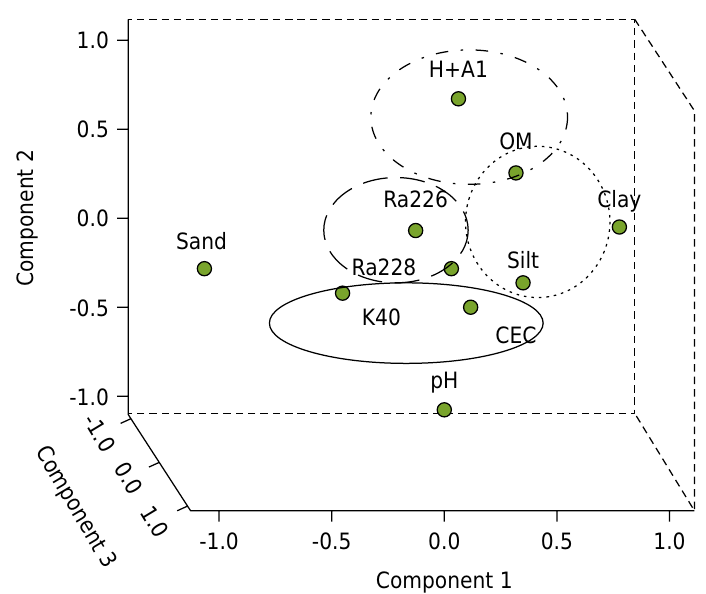
Figure 2. Diagram of principal component analysis (PCA). OM: organic matter; CEC: cation exchange capability.